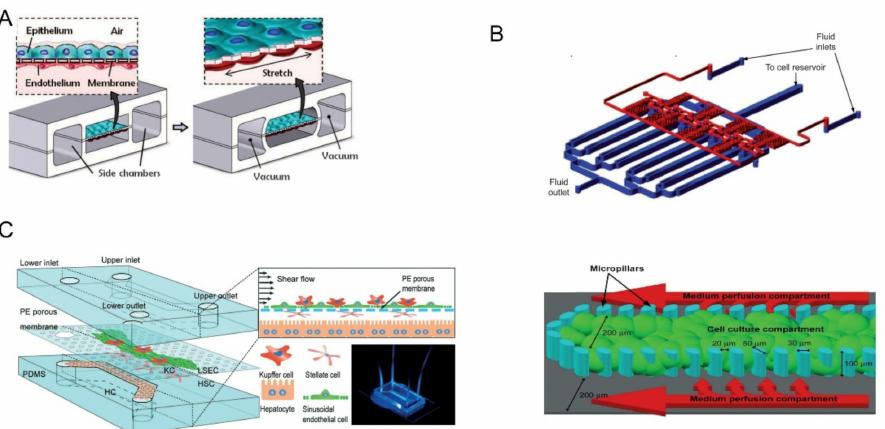
Figure 2. ( A ) The upper layer was alveolar epithelial cells and the lower layer was pulmonary mi- crovascular endothelial cells. Biomechanical activity under respiration can be simulated by circulating vacuums on both sides of the chambers. Reprinted with permission from Ref. [8]. Copyright 2010 Science. ( B ) The multiplexed cell culture chip (blue) and the linear concentration gradient generator (red) were independently manufactured and connected with each other through stainless steel subcu- taneous catheter. Single cell culture channels were divided by microcolumns into central cell culture compartments and two lateral culture medium infusion chambers. Reprinted with permission from Ref. [34]. Copyright 2009 Royal Society of Chemistry. ( C ) The upper and lower channels were made of PDMS and separated by a PE film. Four kinds of cells were distributed layer-by-layer on both sides of PE membrane. Reprinted with permission from Ref. [35]. Copyright 2017 Royal Society of